Question: Provide a one-line summary of what is displayed.
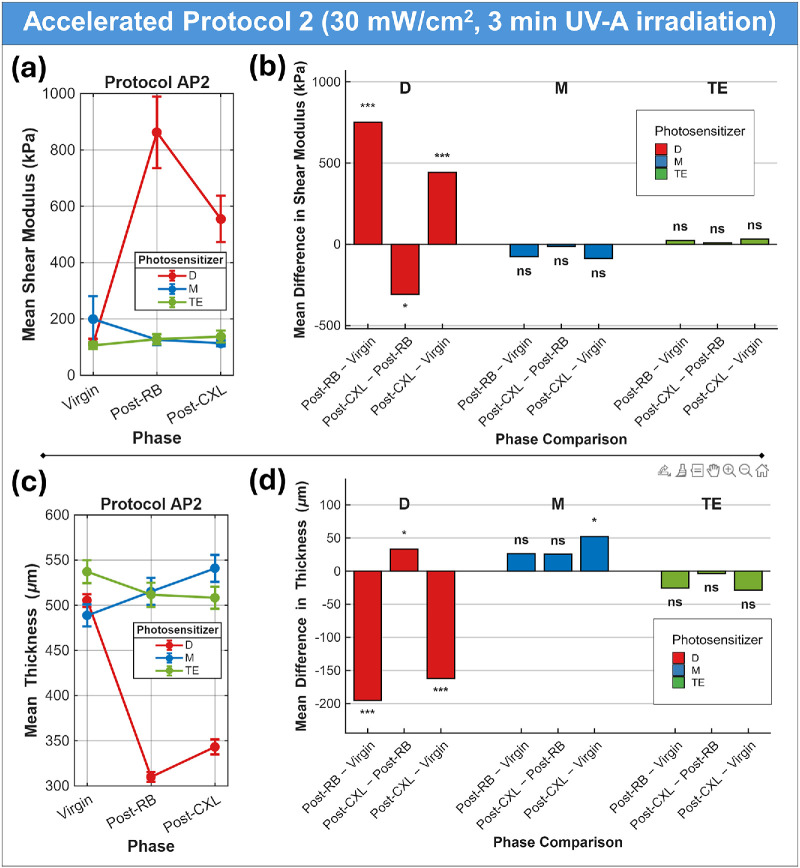
Answer: AP-2 statistical results. ( a ) Estimated average shear modulus with 95% confidence limits vs. treatment phase for all RB photosensitizers. ( b ) LME-predicted mean difference of shear modulus across phases: Virgin → Post-RB, Post-RB → Post-CXL, and Virgin → Post-CXL for all RB photosensitizers. ( c ) Estimated average corneal thickness with 95% confidence limits vs. treatment phase for all RB photosensitizers. ( d ) LME-predicted mean difference of corneal thickness across phases: Virgin → Post-RB, Post-RB → Post-CXL, and Virgin → Post-CXL for all RB photosensitizers. Significant differences are presented as *** P < 0.001; ** P < 0.01; and * P < 0.05. ns, not significant.